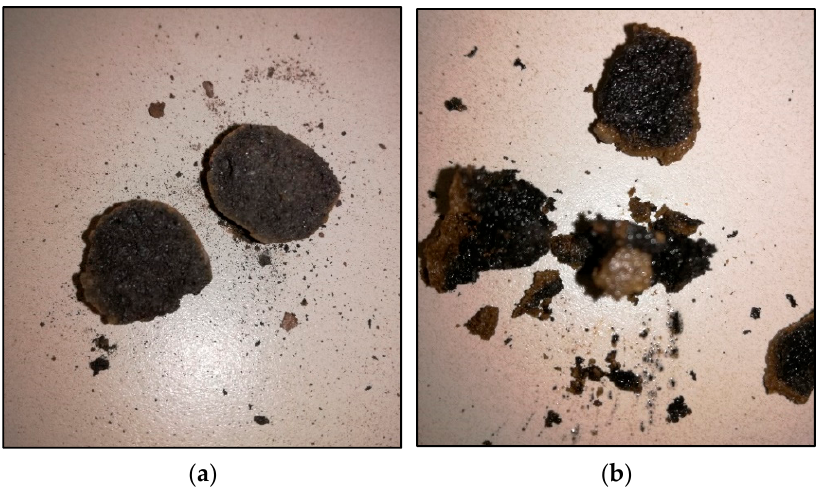
Figure 12. Fracture surfaces of ( a ) LECA and ( b ) GP-LECA-PCM.